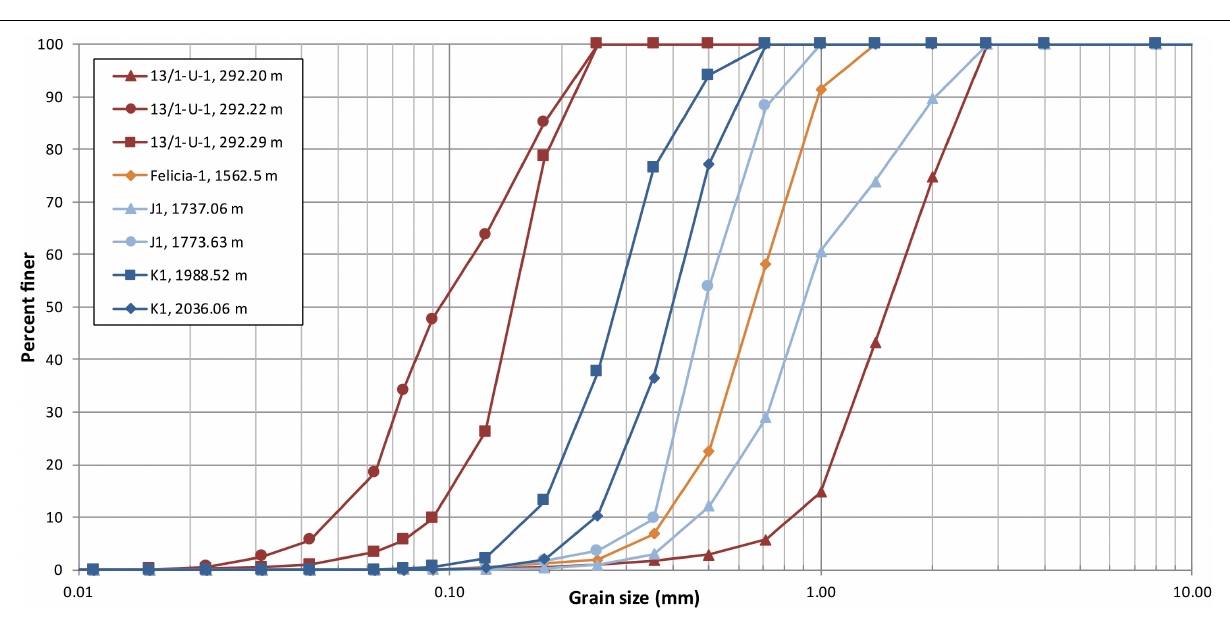
FIGURE 8 | Grain-size distributions of the Gassum Formation in the Skagerrak measured in thin